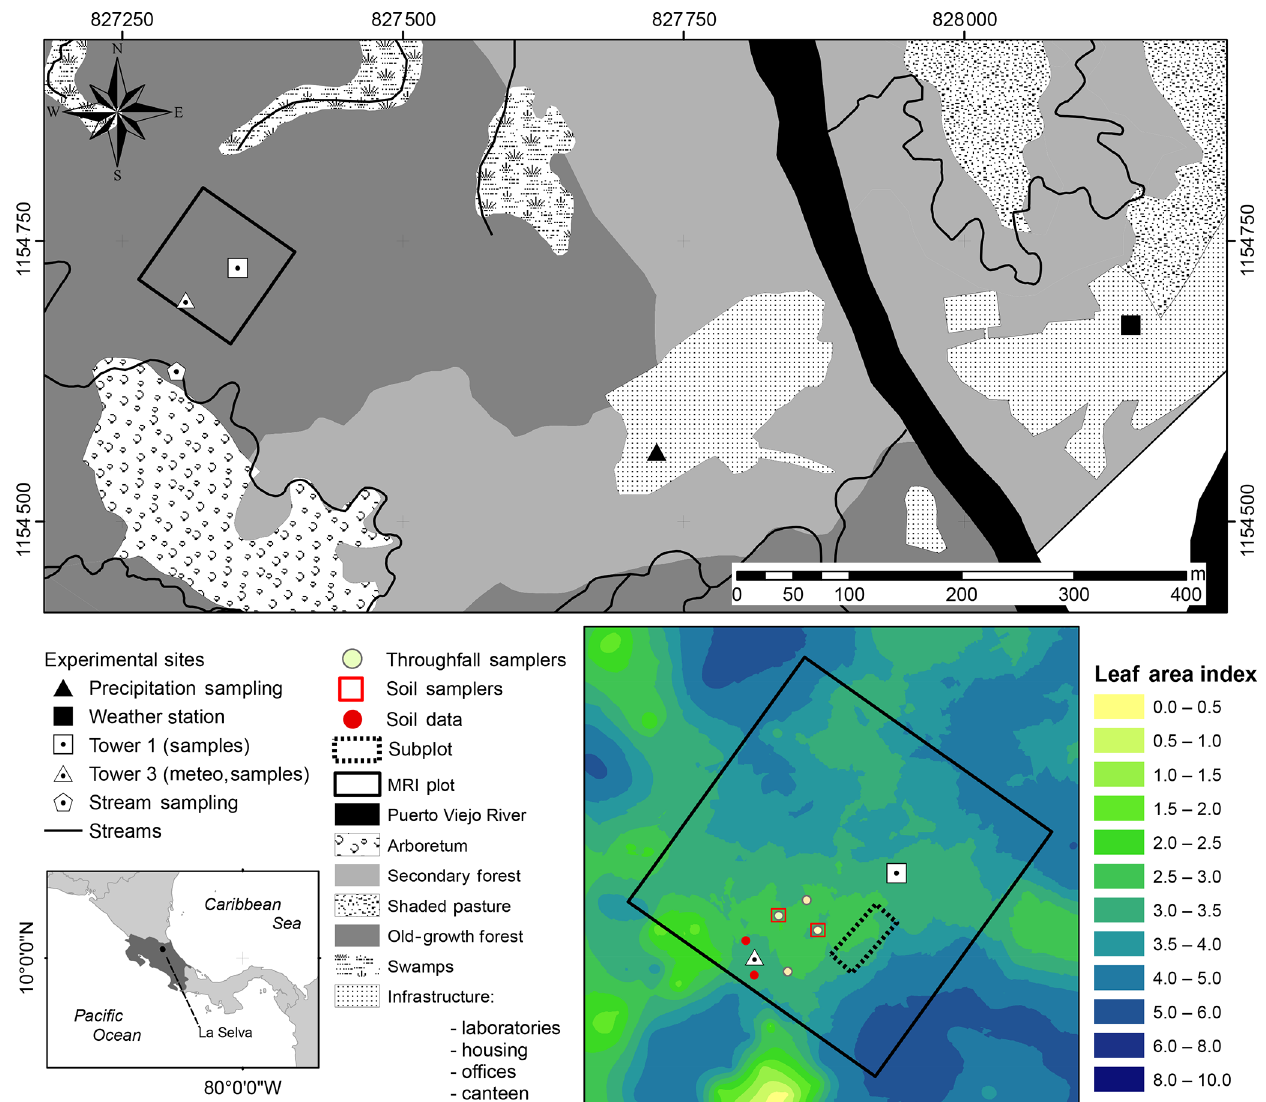
Figure 1. Location of sampling points and the major research infrastructure (MRI plot) plot at La Selva Biological Station in Puerto Viejo de Sarapiquí, Costa Rica. The land cover map shows the location of the MRI plot in the old-growth forest and the bottom-left image depicts the leaf area index (LAI) distribution in the